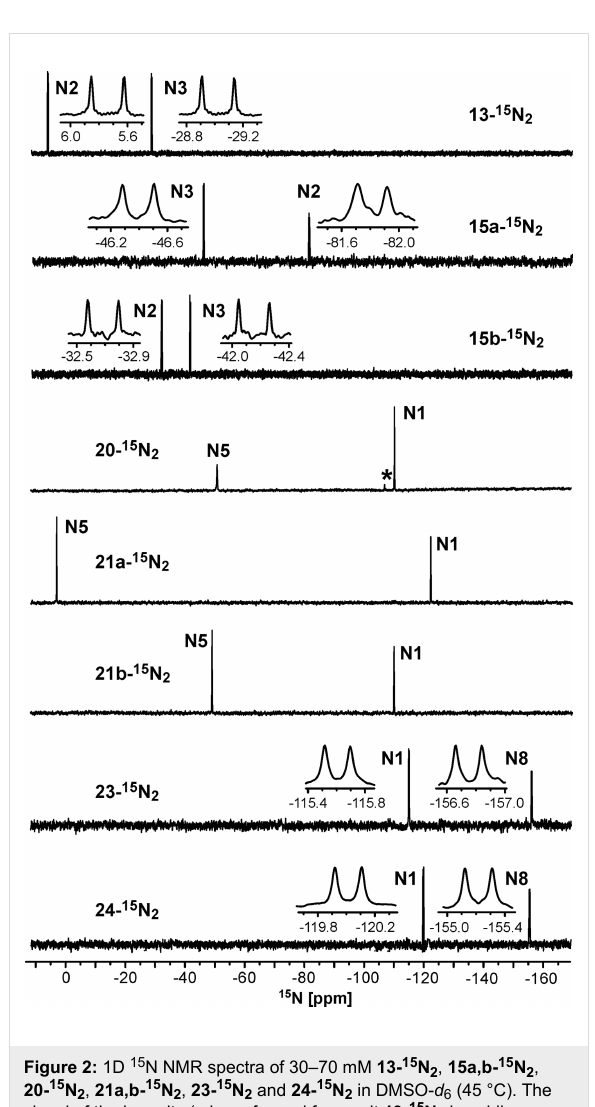
Figure 2: 1D 15 N NMR spectra of 30–70 mM 13- 15 N 2 , 15a,b- 15 N 2 , 20- 15 N 2 , 21a,b- 15 N 2 , 23- 15 N 2 and 24- 15 N 2 in DMSO- d 6 (45 °C). The signal of the impurity (a base formed from salt 19- 15 N 2 in acidic medium) is marked by an